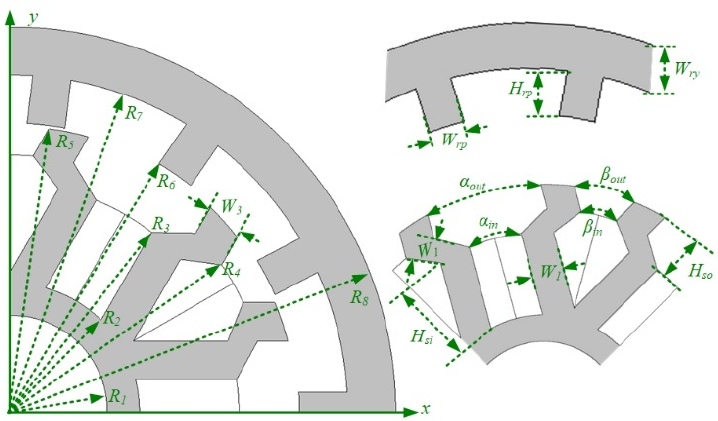
Figure 2. Depicted design parameters of proposed OR-FEFSM.